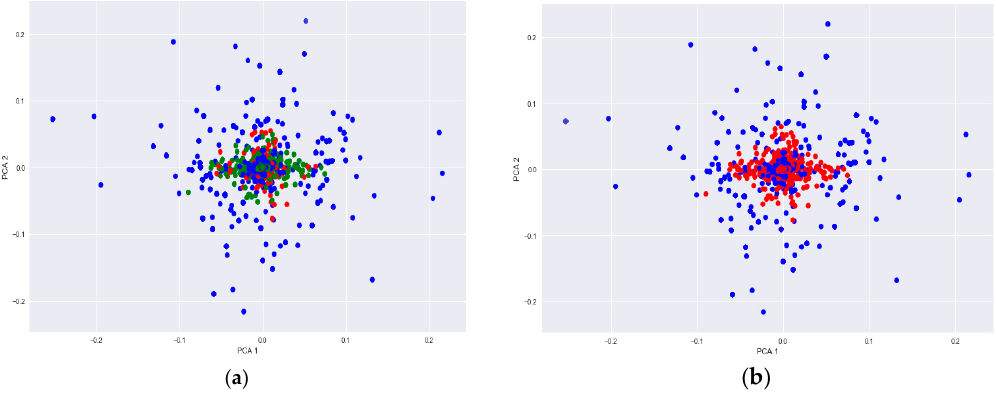
Figure 5. Principal Component Analysis (PCA) Visualization ( a ) Three class visualization results where blue dots represent Neutral, red dots represent pro-Taliban and green dots represent pro-Afghan government (i.e., anti-Taliban). ( b ) Two class visualization results where blue dots represent Neutral and red dots represent tweets having extreme views (i.e., combining classes pro-Taliban and pro-Afghan government).